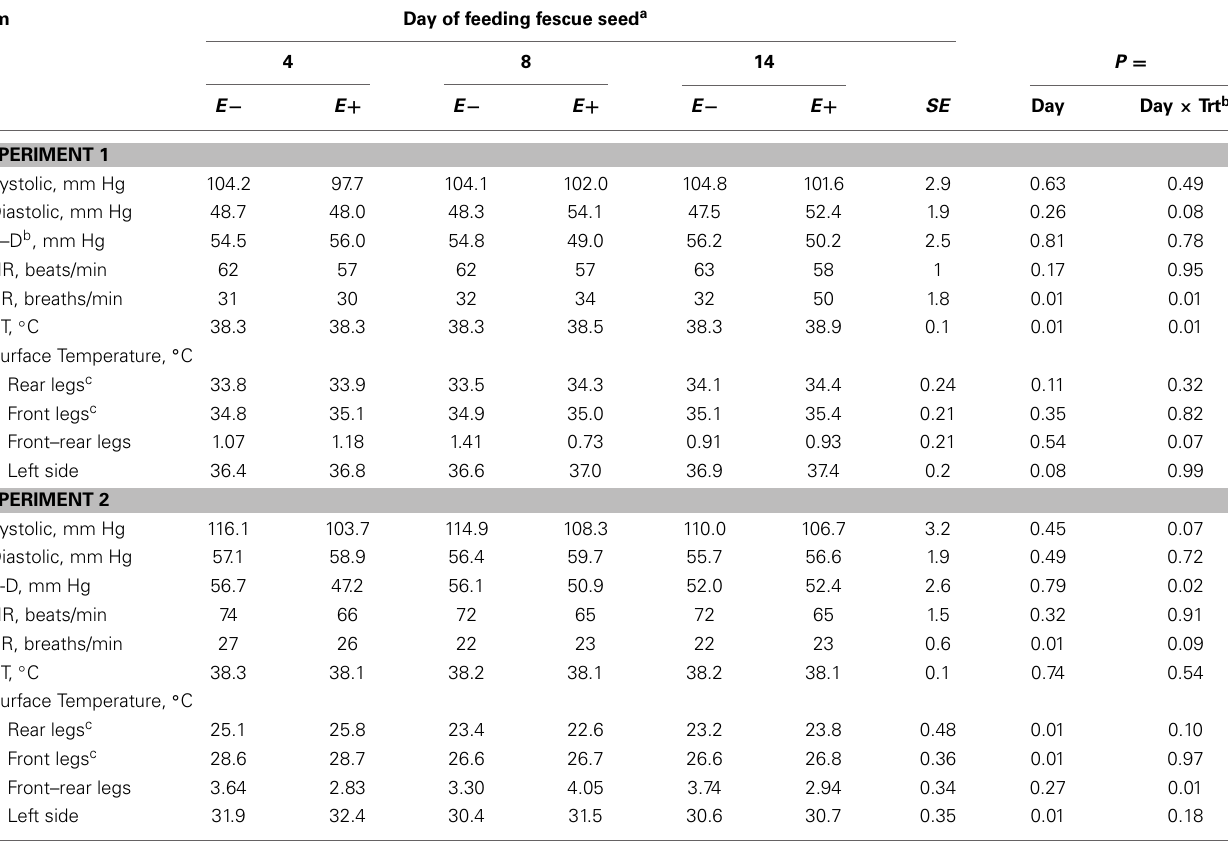
Table 4 | Blood pressure, heart rate (HR), respiration rate (RR), rectal temperature (RT), and surface temperature for steers fed endophyte-free (E − ) or endophyte-infected (E + ) fescue seed for 14 d above (Experiment 1) or within (Experiment 2) their thermoneutral zone.